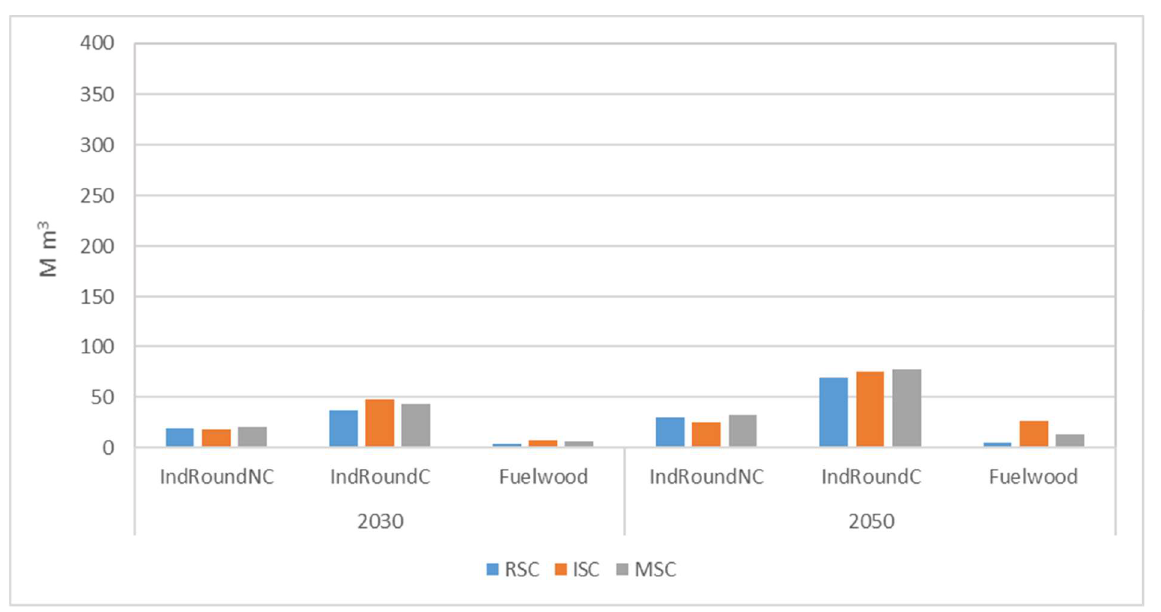
Figure 4. EU roundwood imports from non-EU countries by wood types in the RSC (blue), ISC (orange) and MSC (grey). IndRoundNC and IndRoundC refers to non-coniferous and coniferous industrial roundwood, respectively [authors’ results].